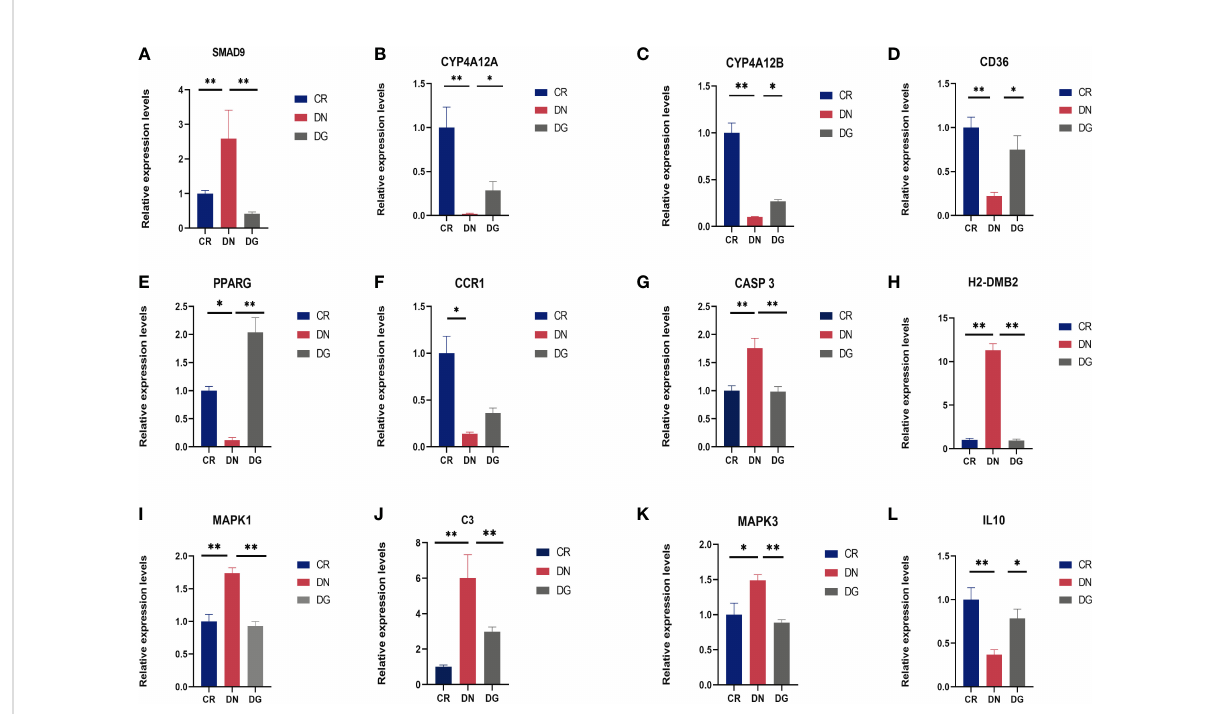
FIGURE 9 (A-L) Validation of key targets by qRT-PCR (n=6). Data are presented as the mean ± SE. *P < 0.05; **P < 0.001. CR, control group; DN, diabetic nephropathy group; DG, dapagli fl ozin